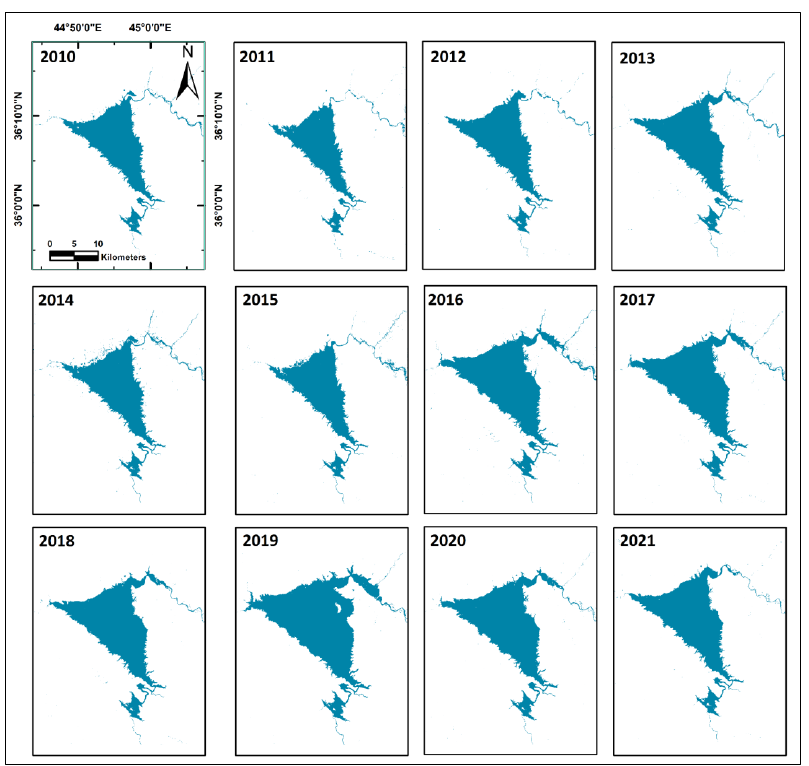
Figure 7. Dukan Lake area change from 2010 − 2021.